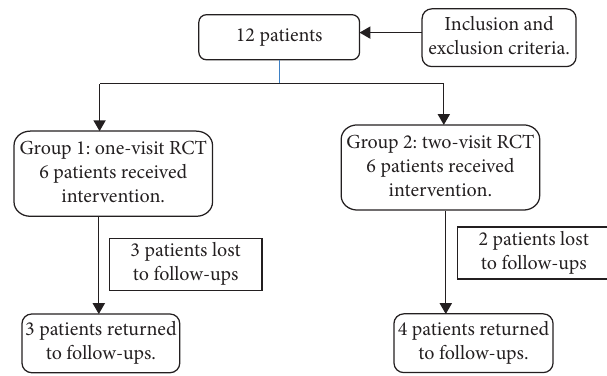
Figure 1: Diagram showing patients’ selection. Table 2: Patient characteristics and outcome